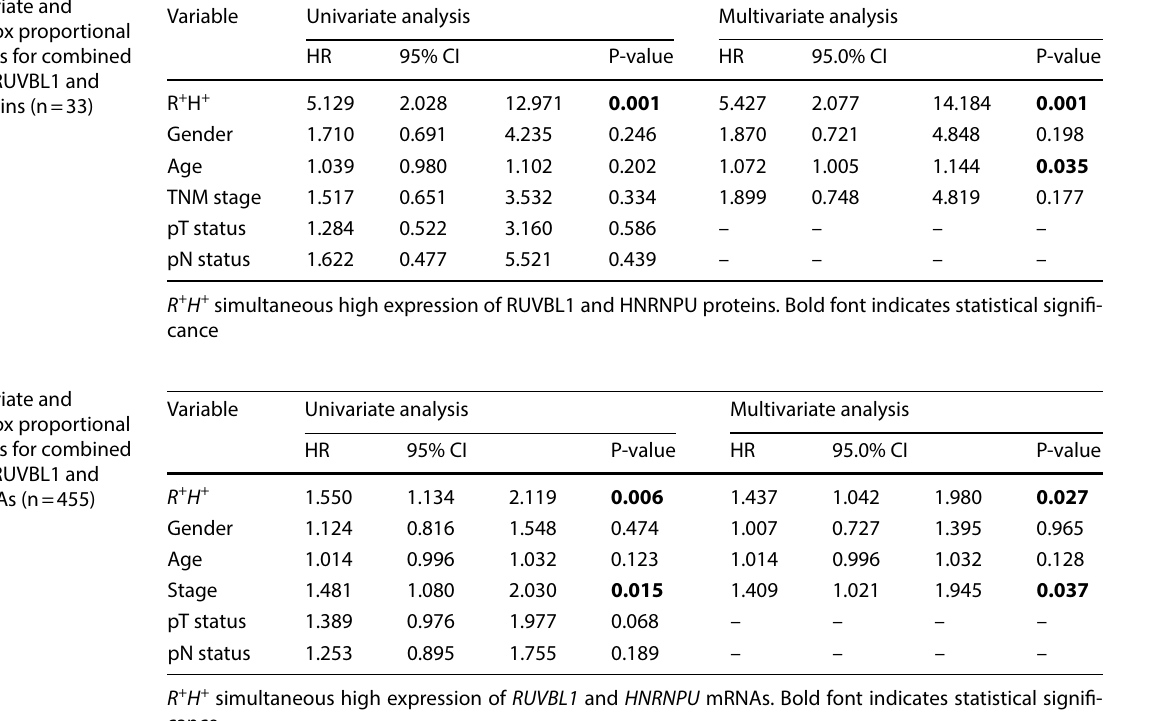
Table 5 Univariate and multivariate Cox proportional hazards models for combined expression of RUVBL1 and HNRNPU proteins (n = 33)